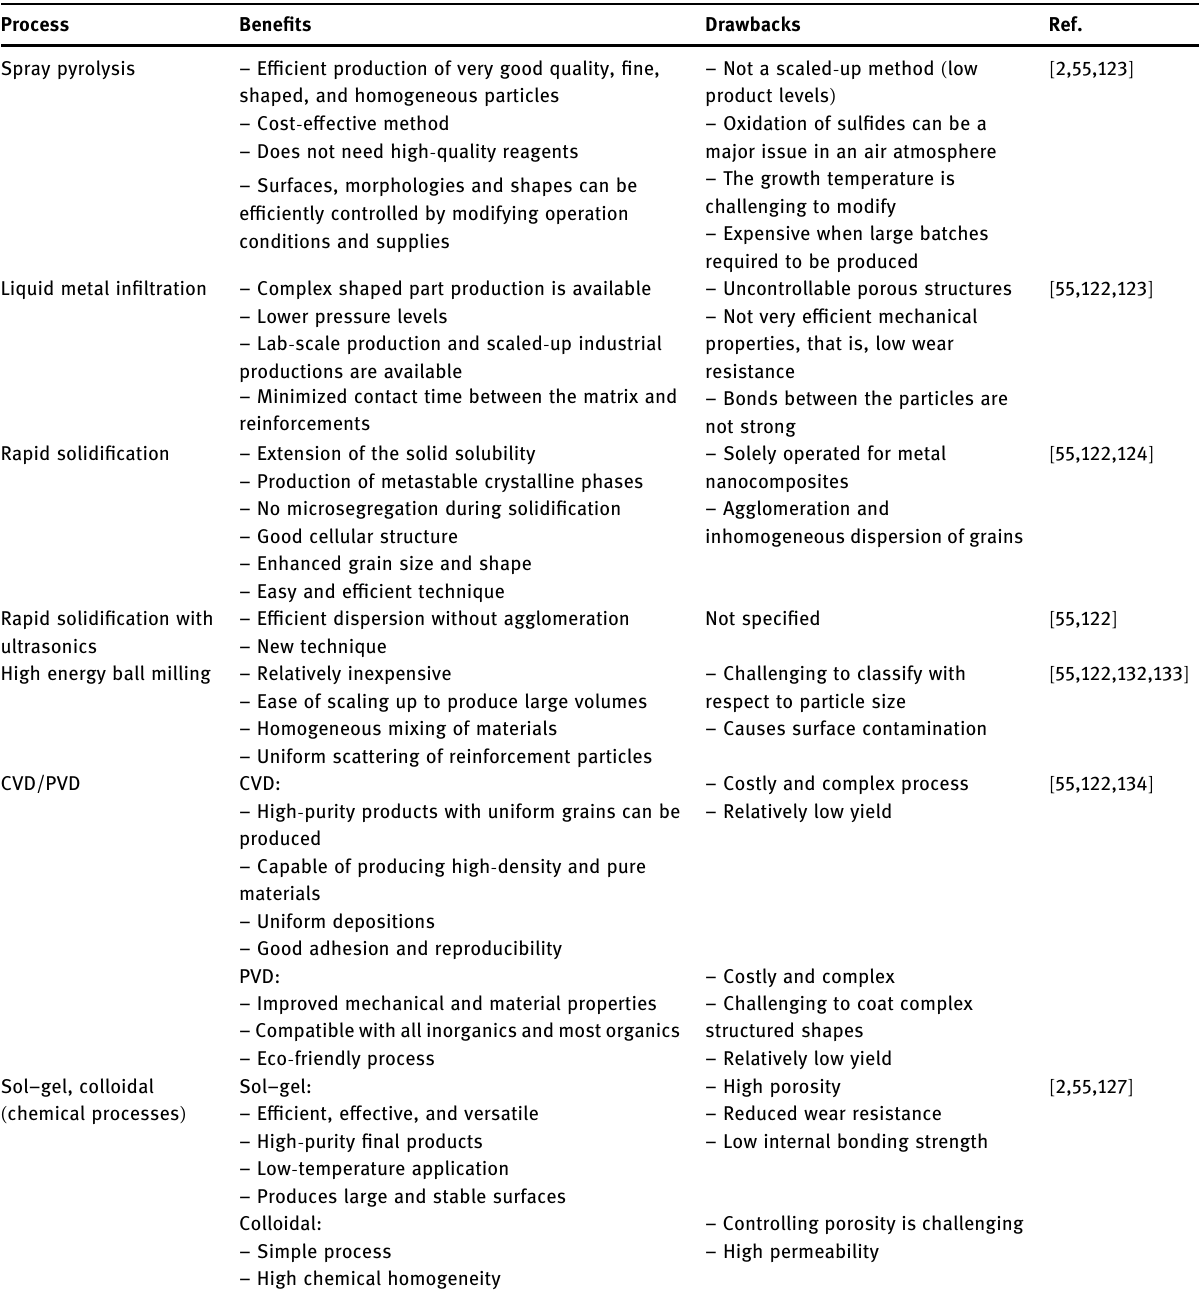
Table 12: MMNC processing techniques along with the relative advantages and disadvantages Process Bene fi ts Drawbacks